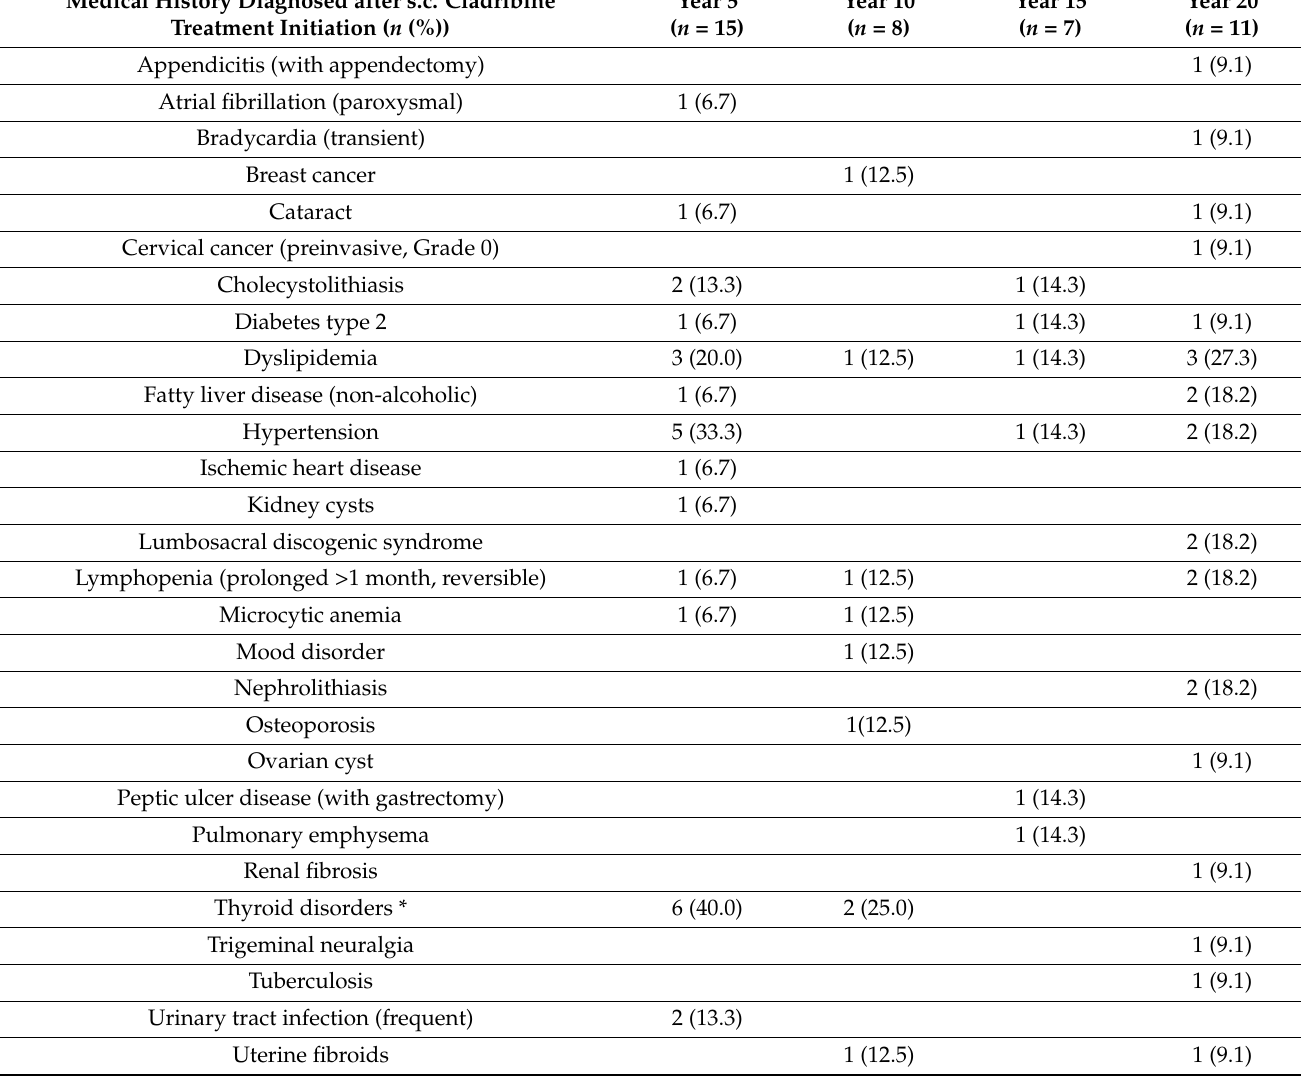
Table 6. History of medical events reported at the final follow-up